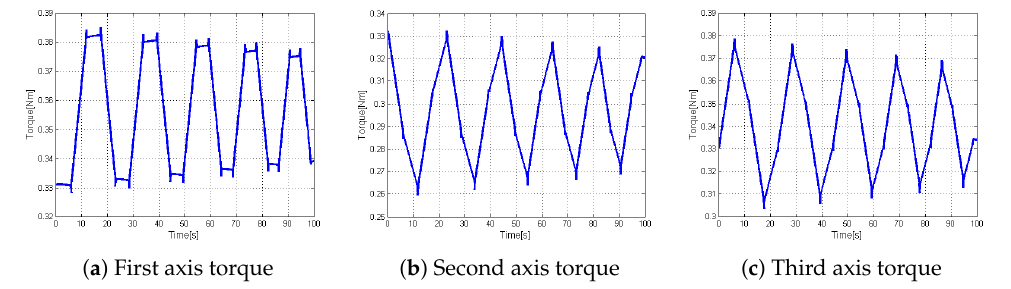
Figure 16. Simulations of motor torques.